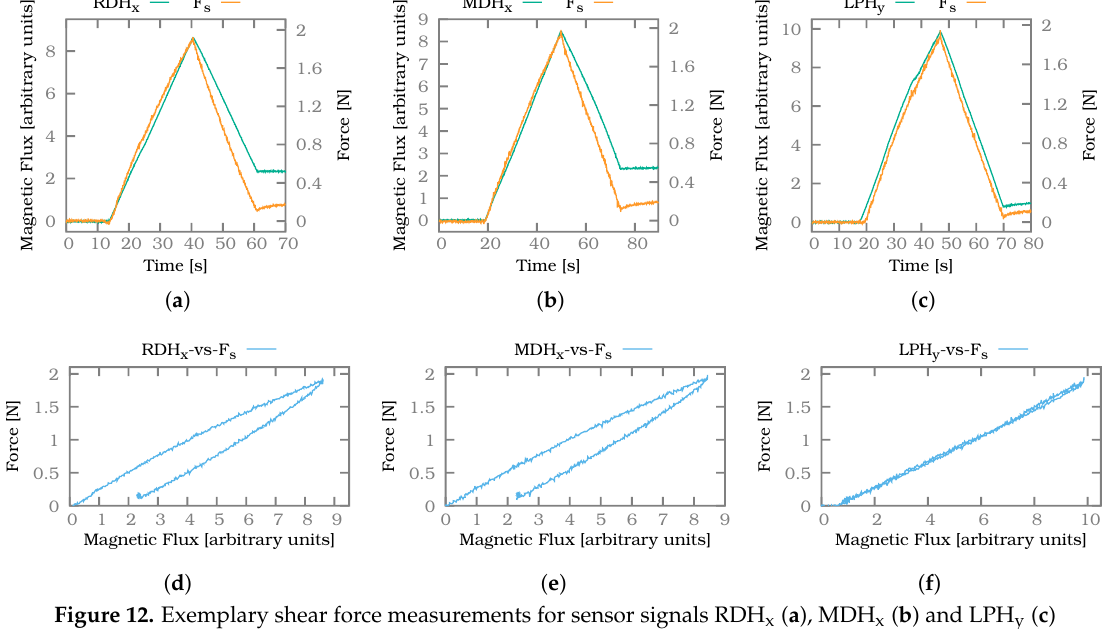
Figure 12. Exemplary shear force measurements for sensor signals RDH x ( a ), MDH x ( b ) and LPH y ( c ) as well as the corresponding hysteresis plots ( d – f